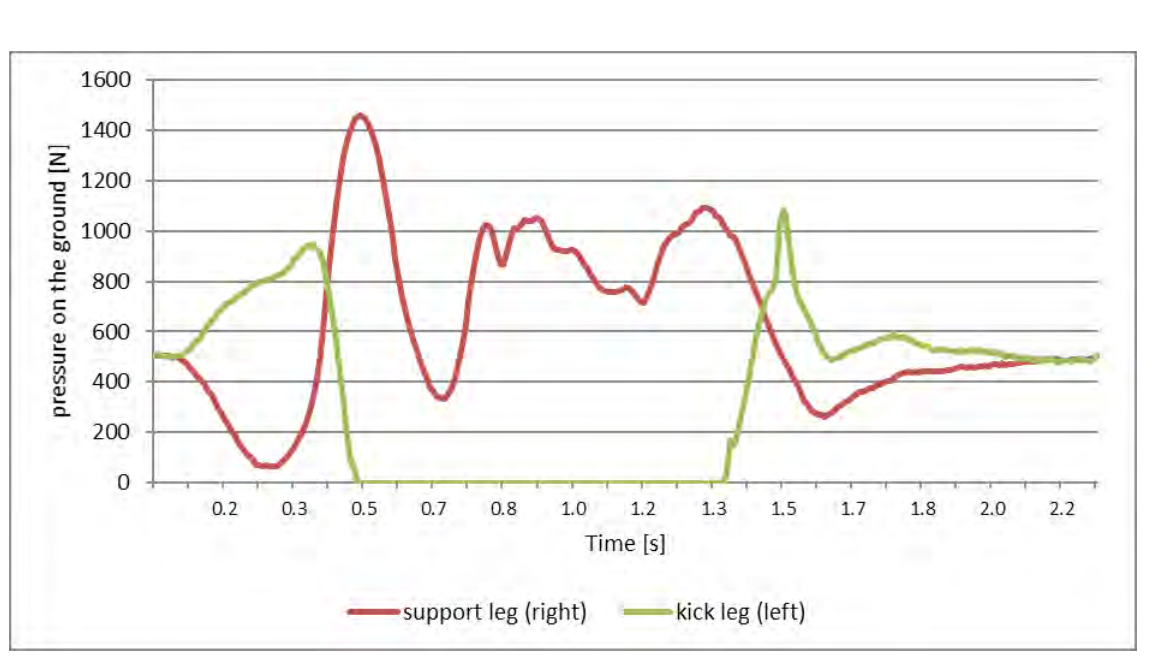
Fig. 2. Changes of foot pressure on the ground while performing the left leg front